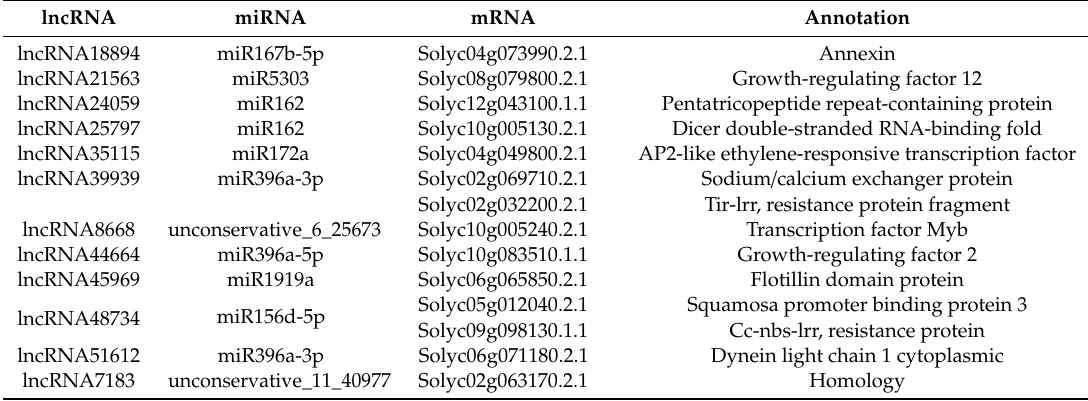
Table 3. Annotation of 12 selected target genes of lncRNAs, miRNAs and